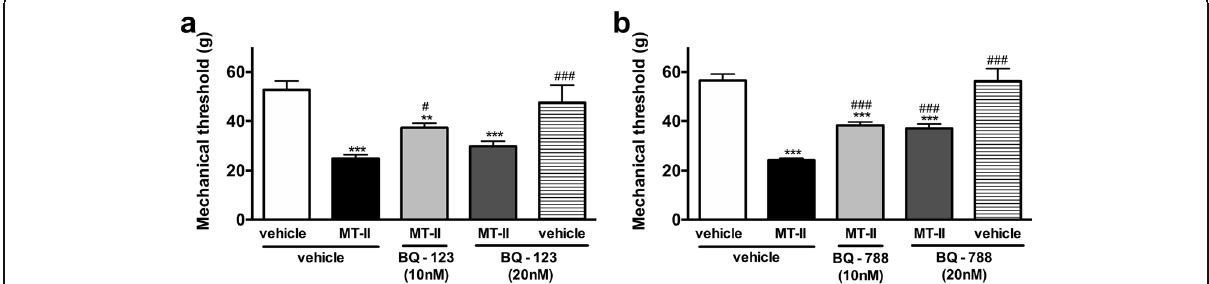
Fig. 7 Involvement of endothelin on MT-II-induced articular hyperalgesia. MT-II (10 μ g/joint) or PBS (vehicle) was injected in tibio-tarsal articulation (25 μ L). Pain threshold was determined using a modified electronic pressure-meter test 8 h after MT-II injection, and represented as force (in g ). a BQ-123 or ( b ) BQ-788 (10 and 20 nmol/joint, selective antagonists of ET-A and ET-B endothelin receptors, respectively) were injected 30